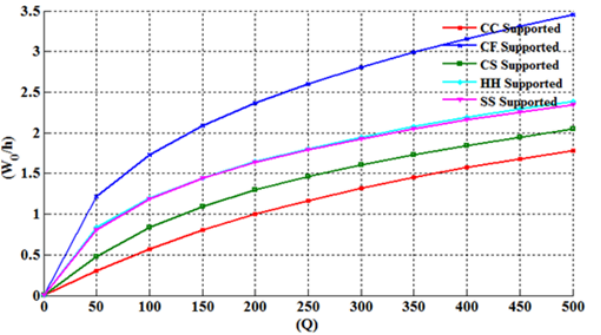
Figure 8 shows the variation in TCD with the variation inloadparameterandSWCNTvolumefractioninthreeand five layered sandwich composite beam made of facesheet and bottom sheet is of single walled carbon nanotube re- inforced composite beam. Lamination scheme for five lay- ered sandwich is [90/30/C/30/90] and for three layered sandwich is [0/C/0]. During the analysis temperature is maintained at 300K, under the C-C boundary condition. As the CNT volume fraction increases in the sandwich com- posite beam, the TCD decreases in the proportion. From the figure, it is observed that, for 0.1% CNT volume frac- tion, there is approximately 51-52% decrease in deflection, for 0.2% CNT volume fraction, there is approximately 47- 48% decrease in deflection, for 0.3% CNT volume fraction, there is approximately 46-47% decrease in deflection and for 0.4% CNT volume fraction, there is approximately 45- 46% decrease in deflection.